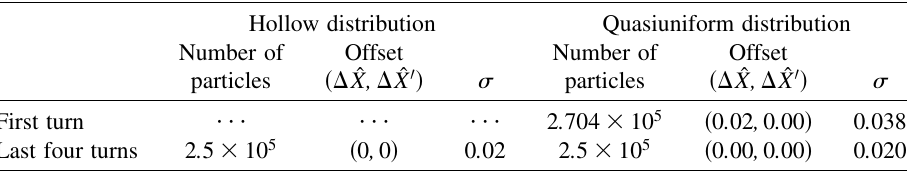
TABLE I. Parameters of the beam distributions of the five injected turns used to generate the final beam distributions shown in Fig. 3. The offset is expressed in the adimensional coordinates and it is referred to the nominal position of the fixed point at the center of the